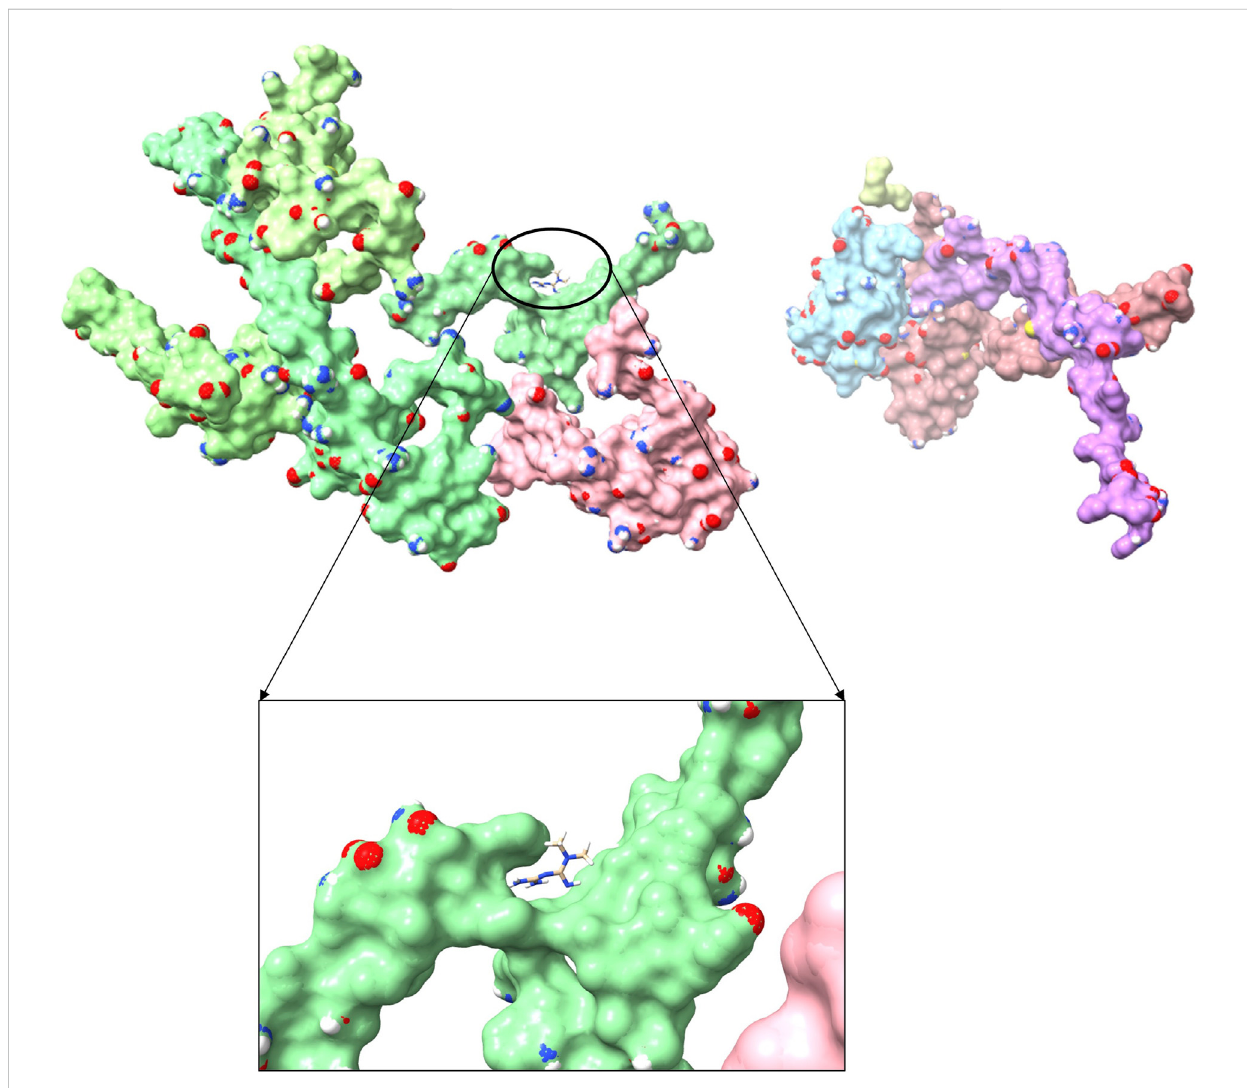
FIGURE 8 The three-dimensional molecular docking diagram of metformin and target protein